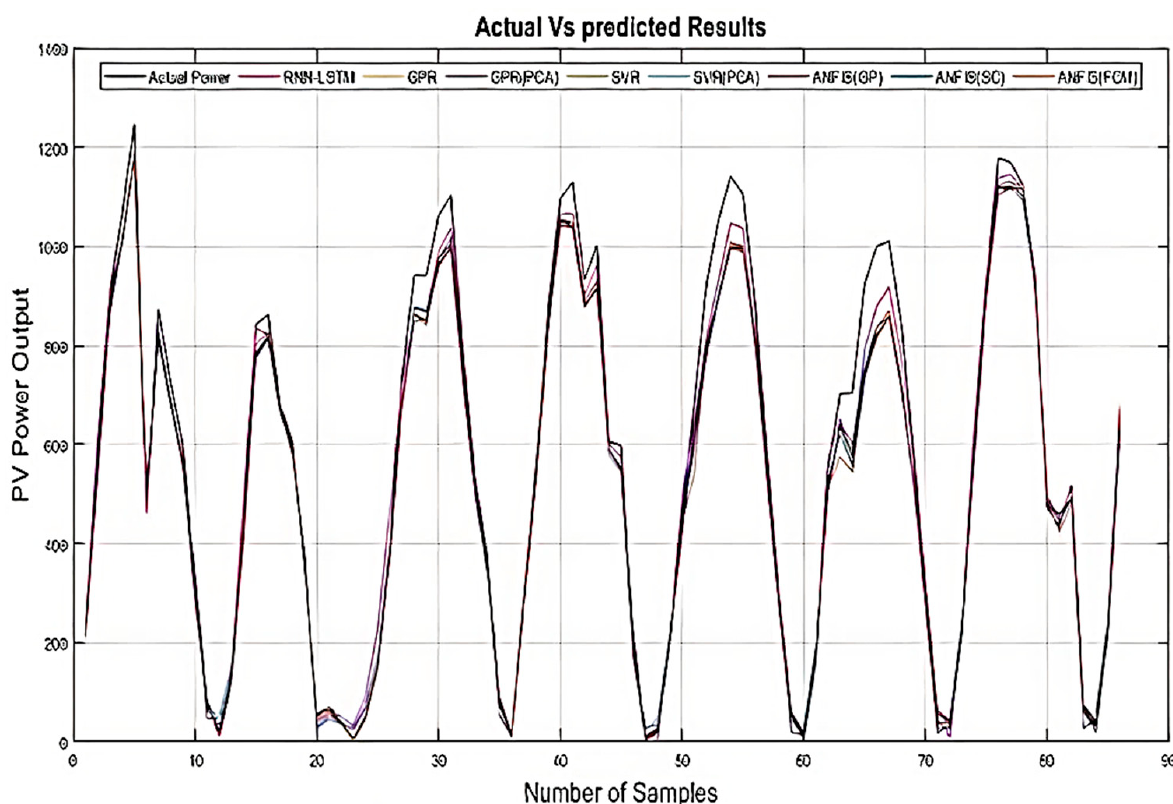
Figure 12. Comparison of RNN-LTSM test results of r and R 2 for a-si with other techniques over the timeframe consisting of four years (2016–2019).